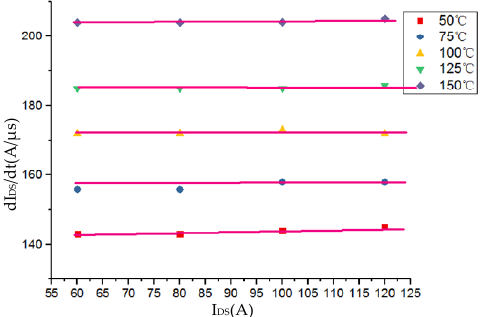
Figure 8. The values of dI DS /dt at different temperatures ( R G ‐ ext = 60 Ω ).